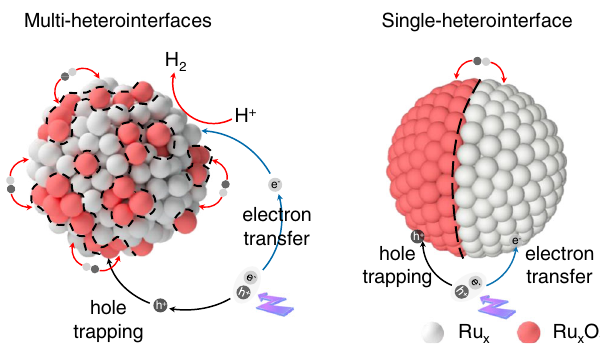
Fig. 1 | Schematic illustration of the catalytic system. Schematic illustration of the solar-driven H 2 evolution system on Ru-RuO x /C 3 N 4 with multiple and single